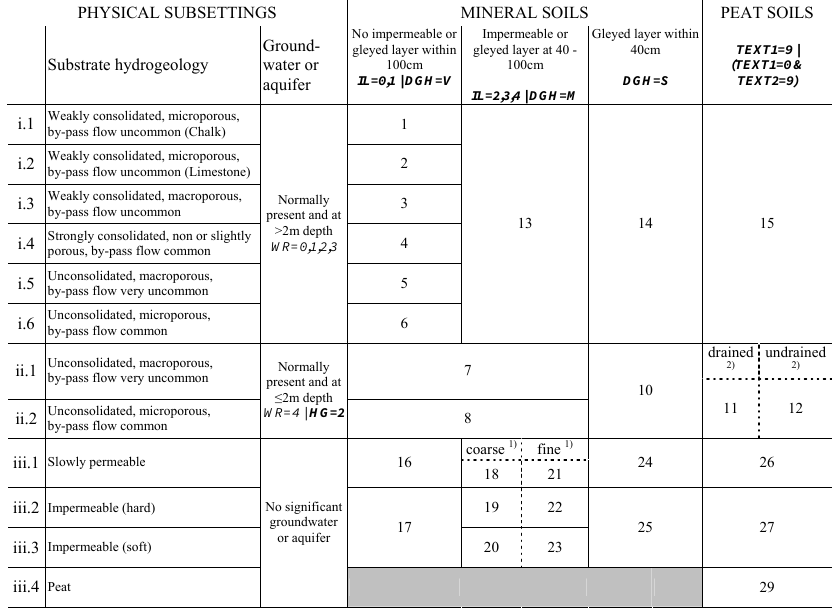
Table 1. Scheme used to reclassify the Soil Geographical Database of Europe (SGDBE) into HOST classes